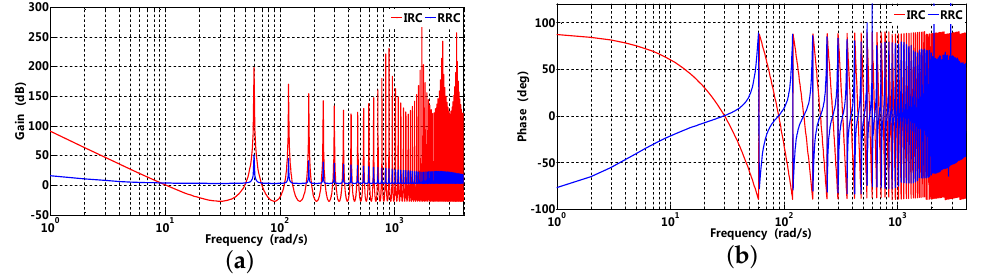
Figure 6. Gain and phase waveforms of IRC and RRC, where corresponding parameters are N = 1044, ω 0 = 60 rad/s, K q = 0.6, D = 2.6 and T s = 0.1 ms. ( a ) gain; ( b )